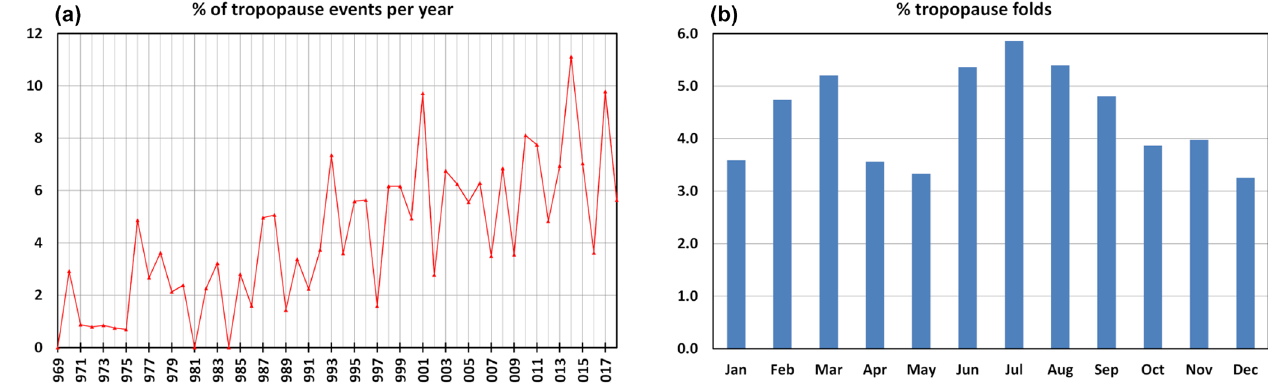
Figure 4. (a) Relative frequency of detected tropopause folding events per year in the ozone soundings at Uccle. (b) Relative frequency of tropopause folding events per